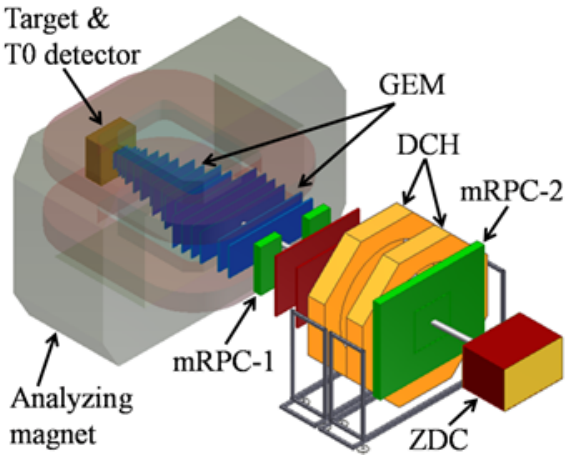
Figure 2. Schematic view of the BM@N setup